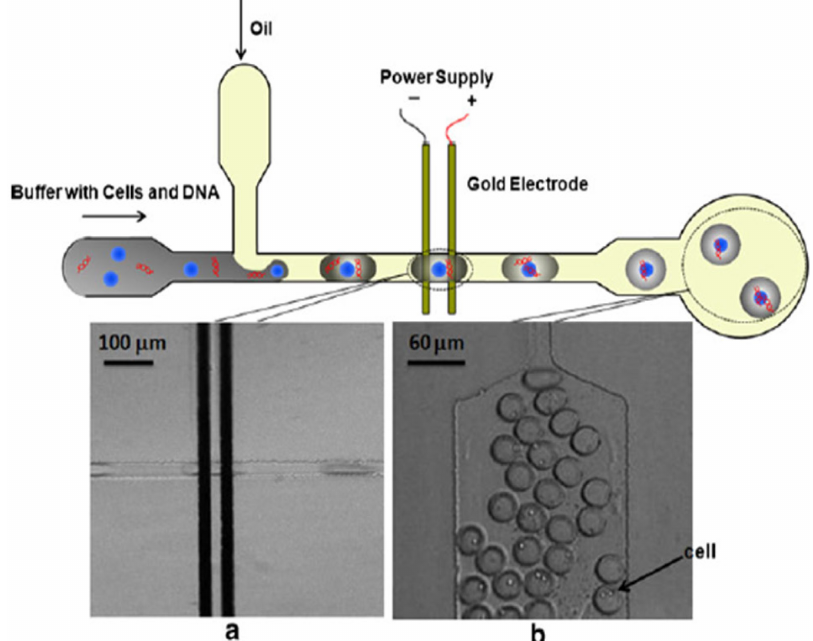
Figure 8. Layout and performance of a droplet based microfluidic device ( a ) two microelectrodes, where cells can be positioned for electroporation; ( b ) after electroporation, a droplet with a cell at the end of the device. Permission to reprint obtained from American Chemical Society (ACS)